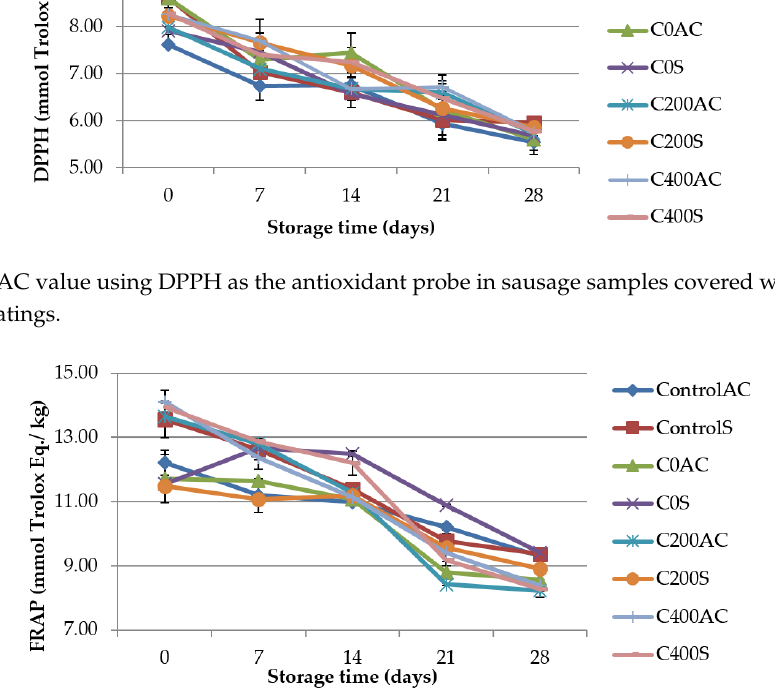
Figure 9. TAC value using FRAP as the antioxidant probe in sausage samples covered with sodium alginate coatings.